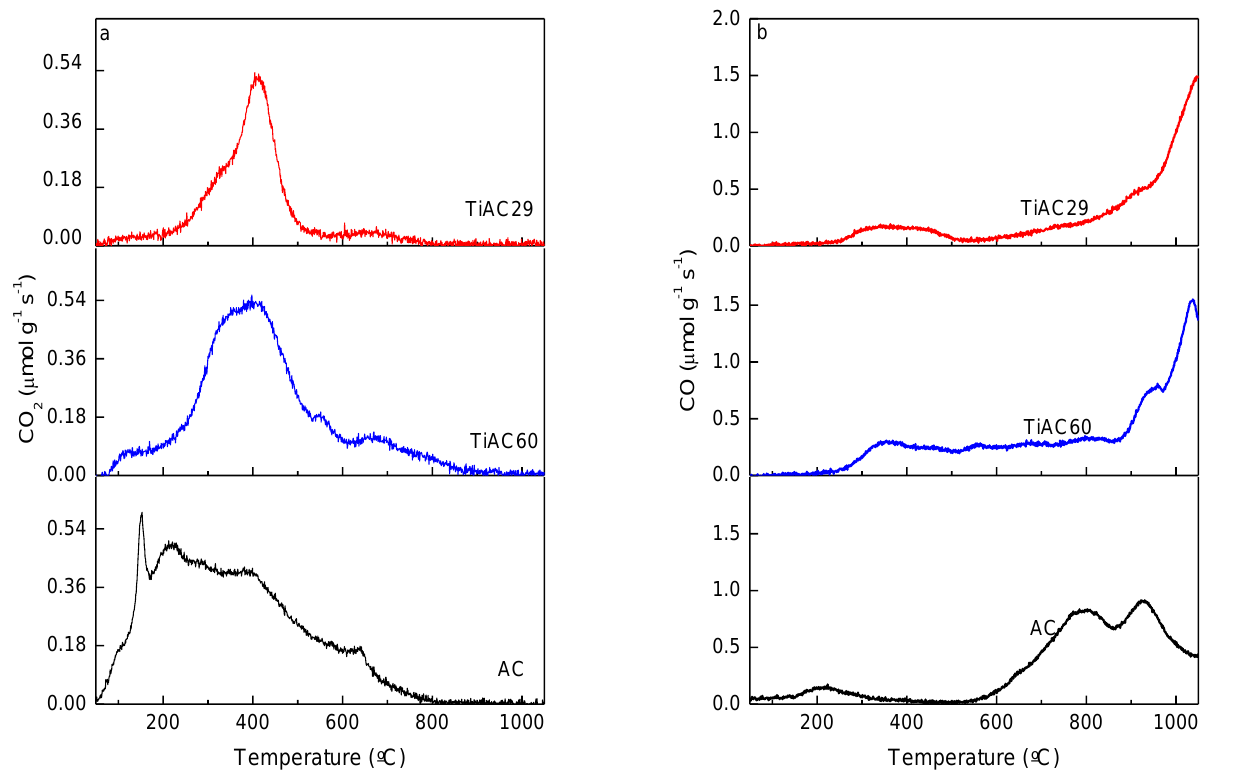
Figure 6. TPD profiles of AC and TiACX composites: ( a ) CO 2 evolution; ( b ) CO evolution. The results presented in Table 3 show that all samples have a higher amount of surface groups decomposing into CO than into CO 2 , pointing out the basic characteristic of these materials. The CO 2 /CO ratios are lower for the composites than for the AC the increase in their basic character to a larger extent for TiAC29, the Ti-richest composite. Table 3. Amounts of CO 2 , CO, and CO 2 /CO ratio on the surface of carbon-based materials determined by TPD.